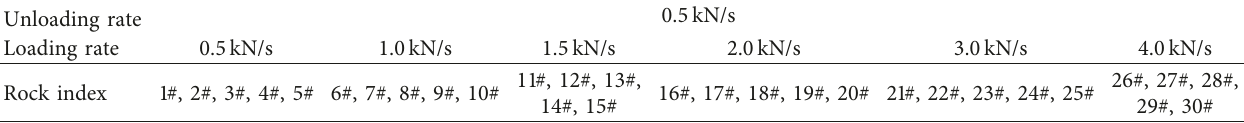
Table 1: Experimental scheme of impacts of uniaxial cyclic loading rates on rock AE characteristics.